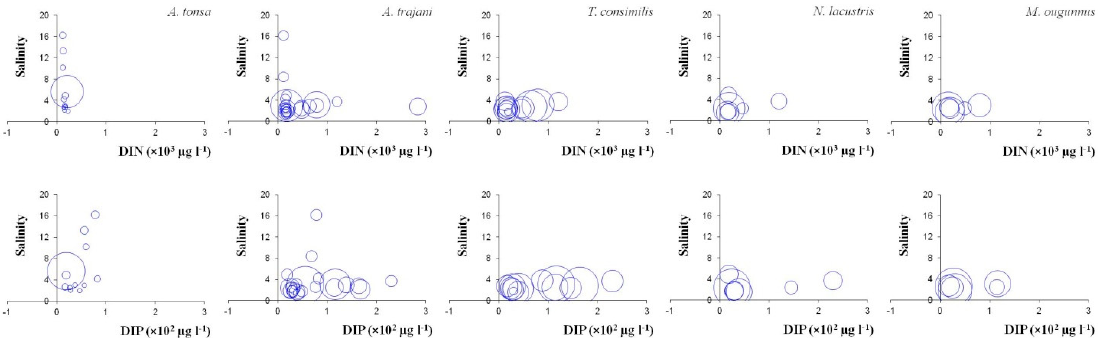
Figure 7. Abundances of Acartia tonsa , Acanthocyclops trajani , Thermocyclops consimilis , Nitocra lacustris , and Mespcyclops ogunnus (these five species represent 96.3% of total adult copepods population) in function of values of salinity, DIN, and DIP at Lake Manzalah. Circles diameters are correlated with abundances. Only adults have been considered.